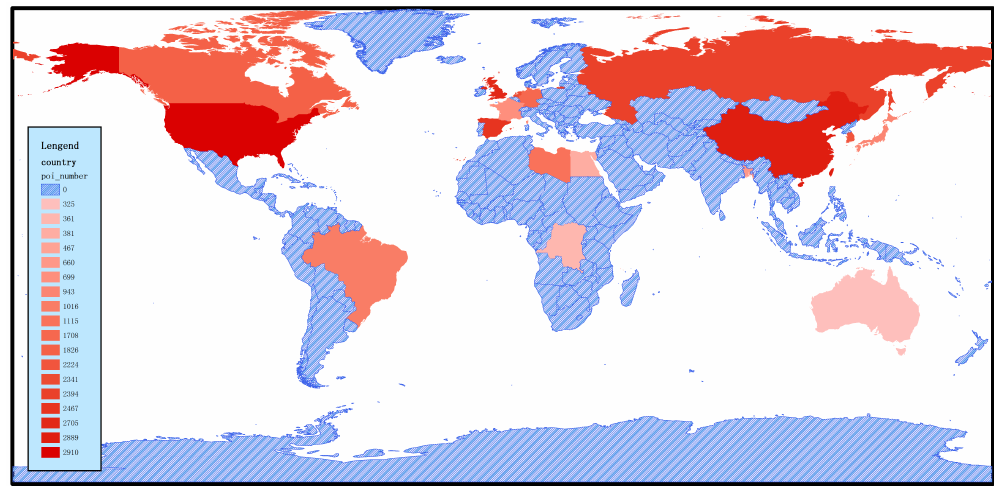
Figure 5. Geographical location and quantity distribution of selected POI. Darker areas indicate greater amounts of POI data selected (the number in the legend indicates the number of POIs selected in the